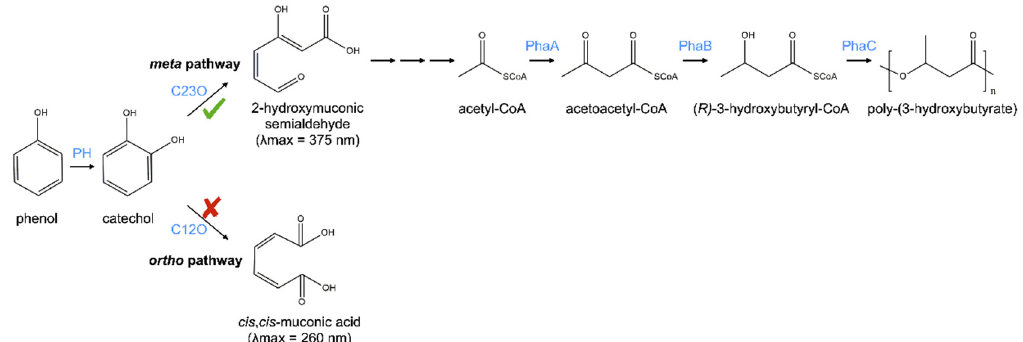
Figure 2. Meta -cleavage pathway of phenol degradation and the synthesis of PHA in Pseudomonas sp. phDV1. Abbreviations of enzymes: PH, phenol hydroxylase; C23O, catechol 2,3-dioxygenase; C12O, catechol 1,2-dioxygenase; PhaA, acetyl-CoA acetyltransferase; PhaB, acetyl-CoA reductase; PhaC, PHA synthase.